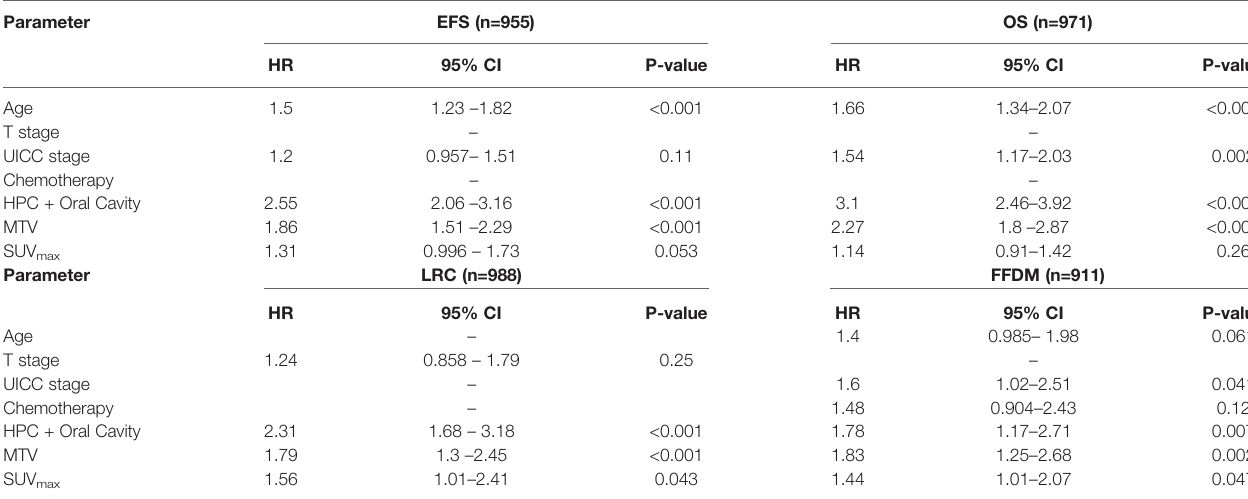
TABLE 2 | Multivariate cox regression analyses with respect to EFS, OS, LRC and FFDM.